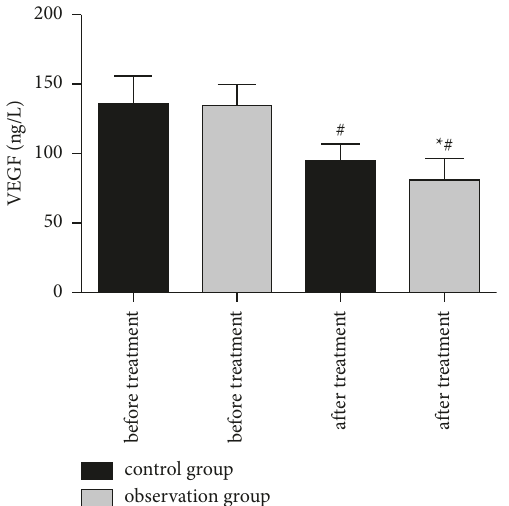
Figure 7: ANGPTL4 levels of two groups of patients at different times. Compared with the same group before treatment, # P < 0 . 05; compared with the control group, ∗ P < 0 . 05.